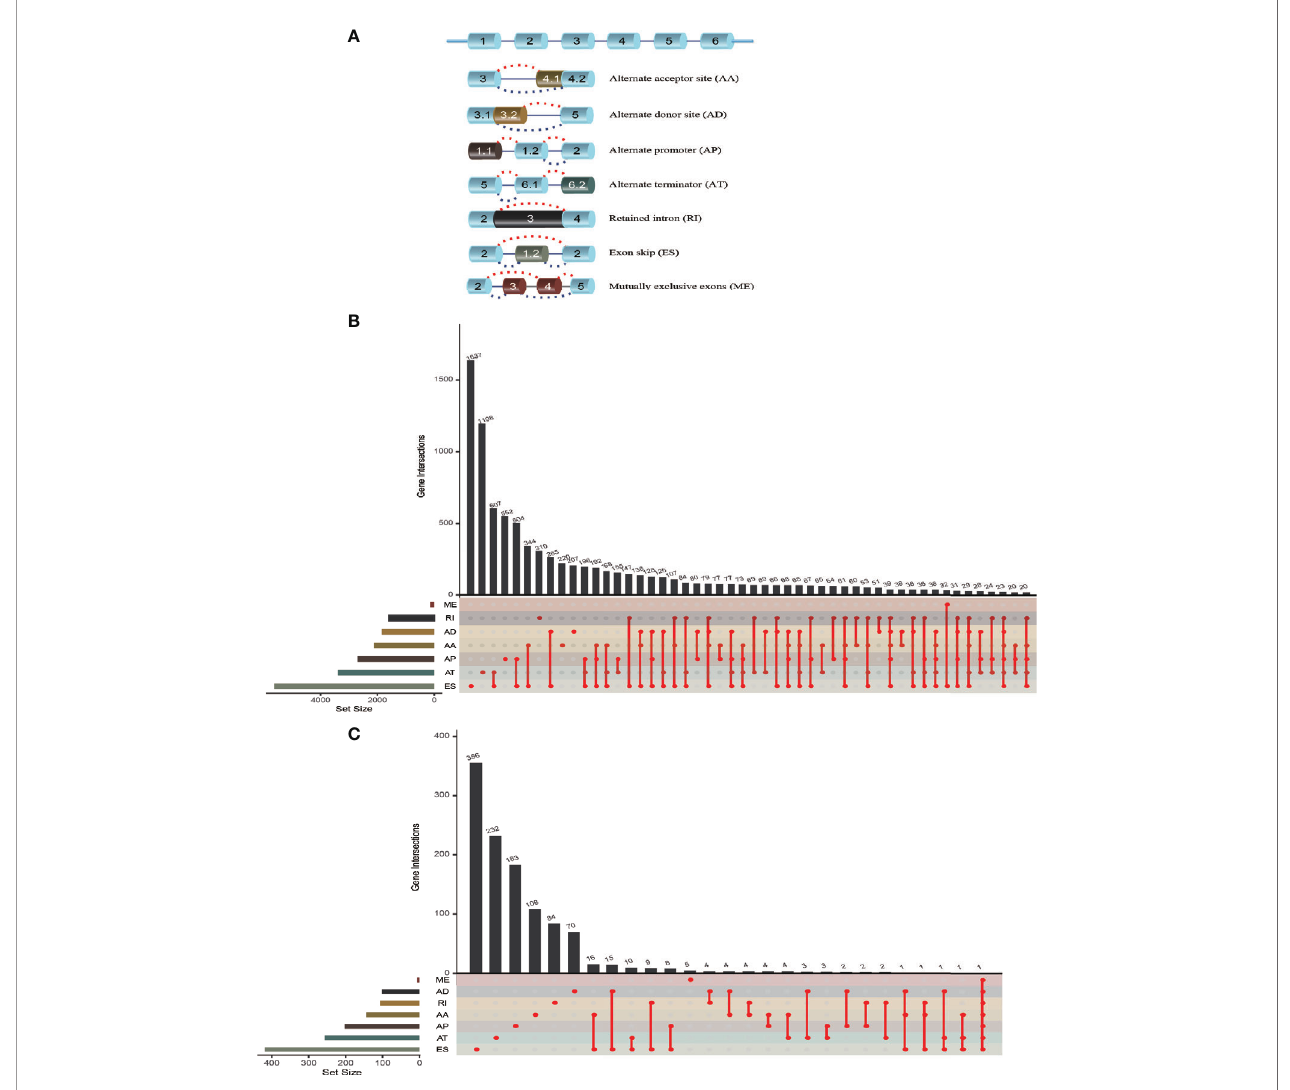
FIGURE 2 | AS event pro fi ling in CRC. (A) Representative model of seven different AS types. (B) UpSet plot of interactions between different AS types in CRC (n = 452). (C) UpSet plot of different survival-associated AS types obtained a univariate Cox regression in